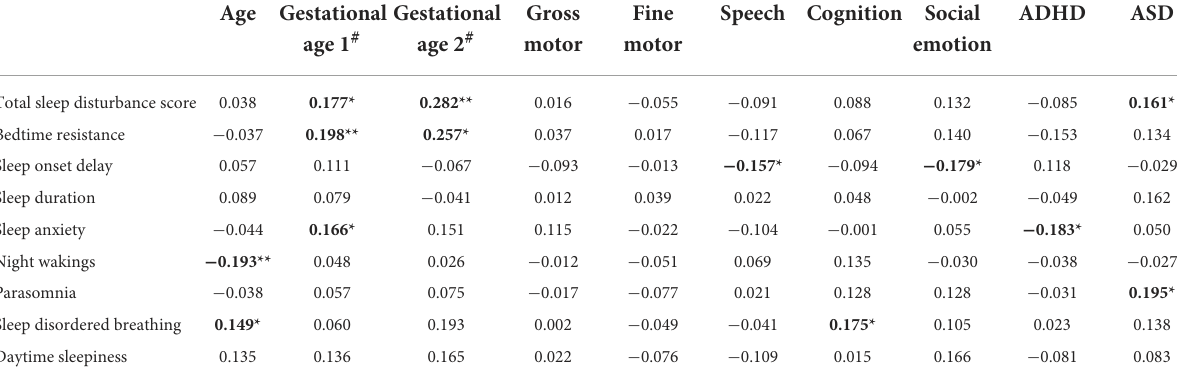
TABLE 3 Correlation between epidemiological and neurodevelopmental status and